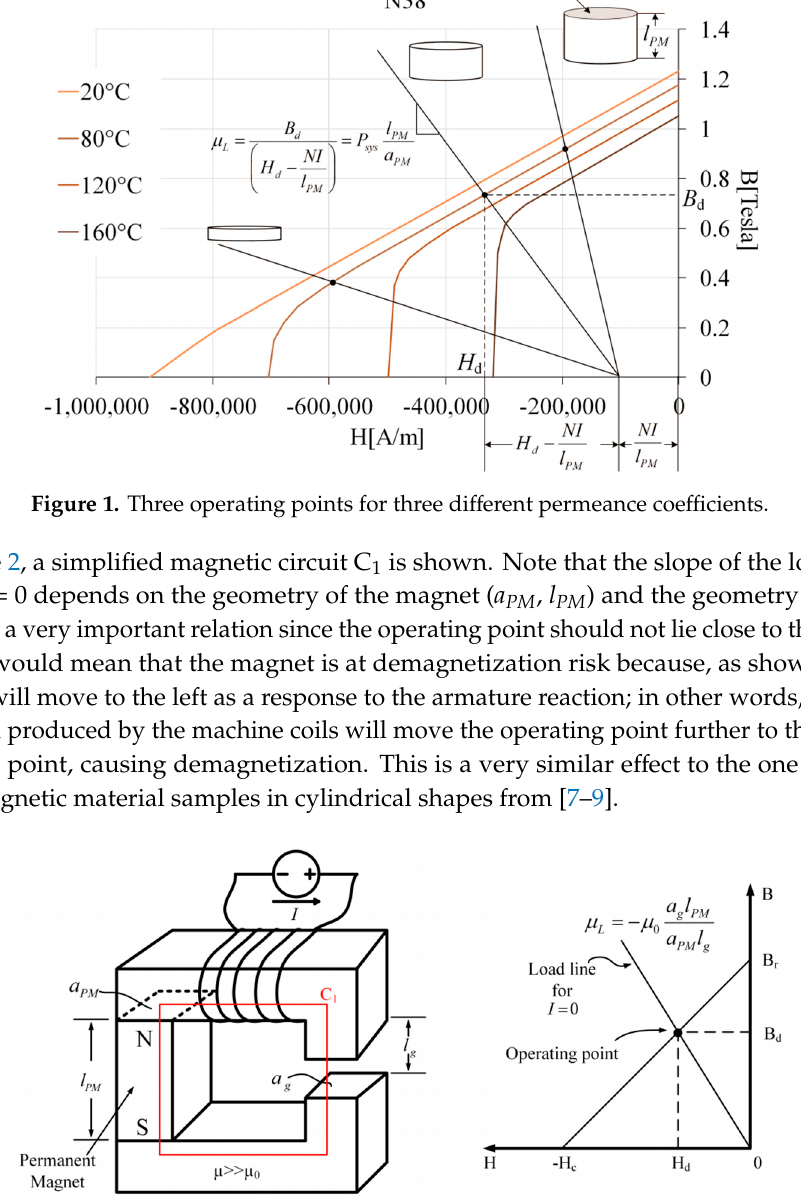
Figure 2. C-core and load line when I = 0 A.